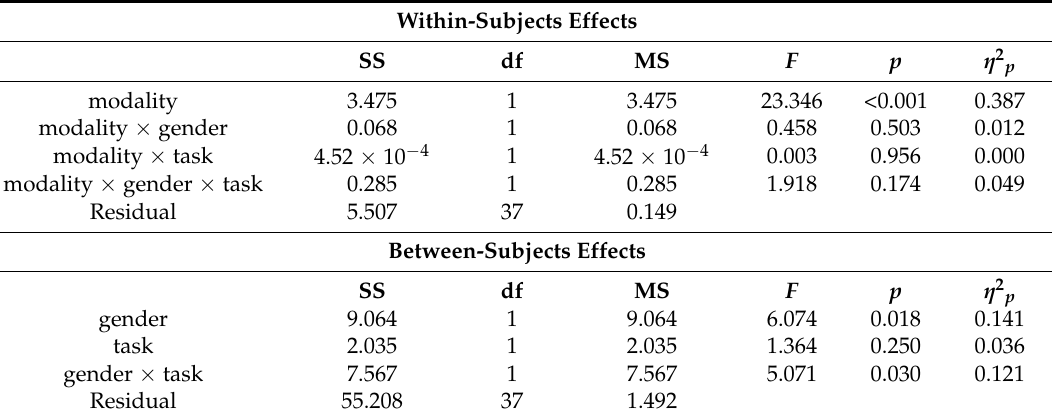
Table A3. Self-assurance.